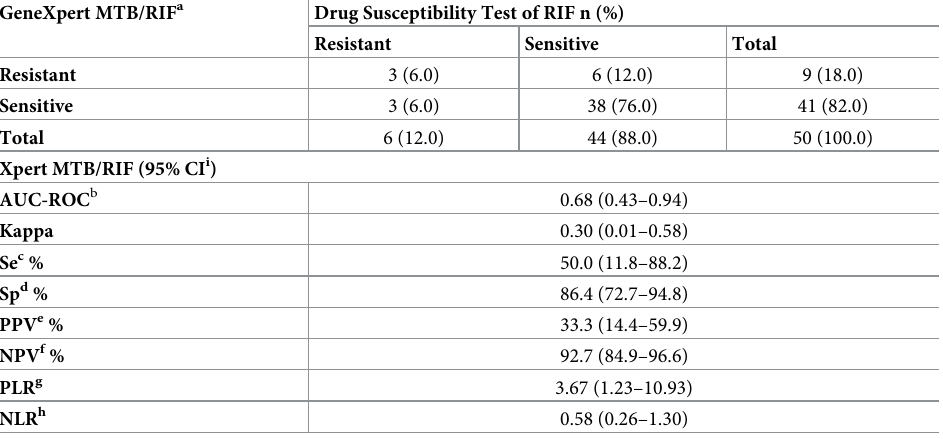
Table 3. Performance of Xpert MTB/RIF assay against standard conventional drug susceptibility test for